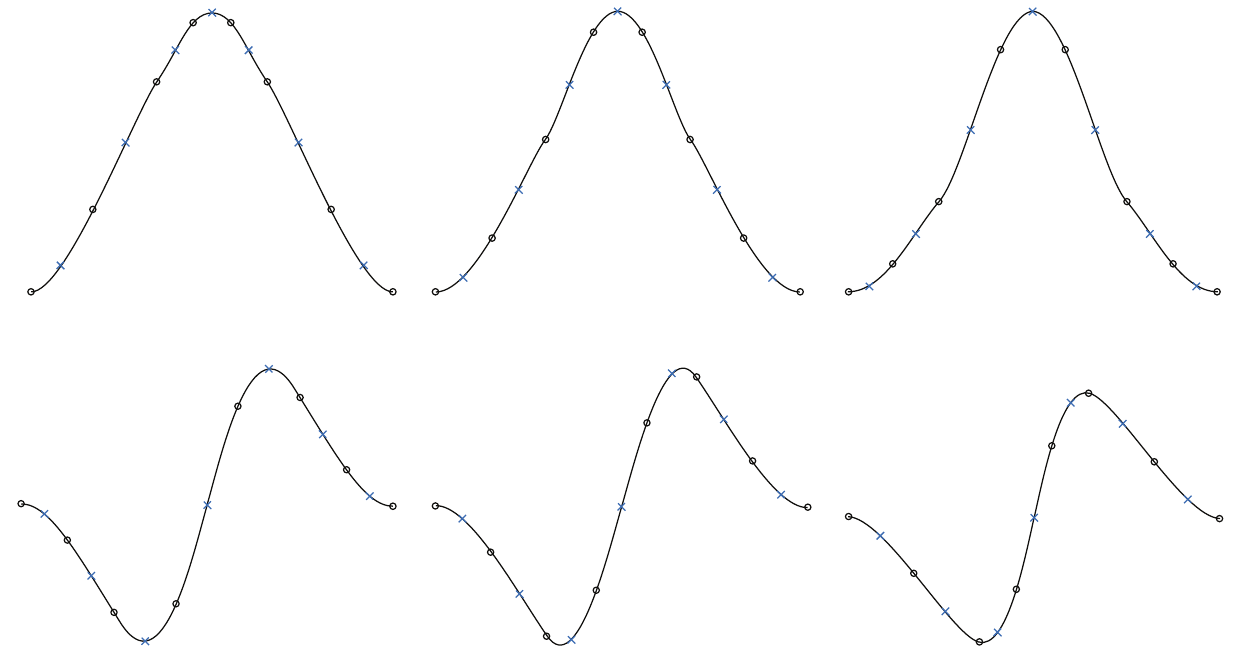
Figure 11: The first two natural modes for a 2-layered beam with centrally located delamination, obtained from Model 2; top: 1st mode shapes. Bottom: 2nd mode shapes; left: 30%, middle: 40%, and right 50% delaminations.